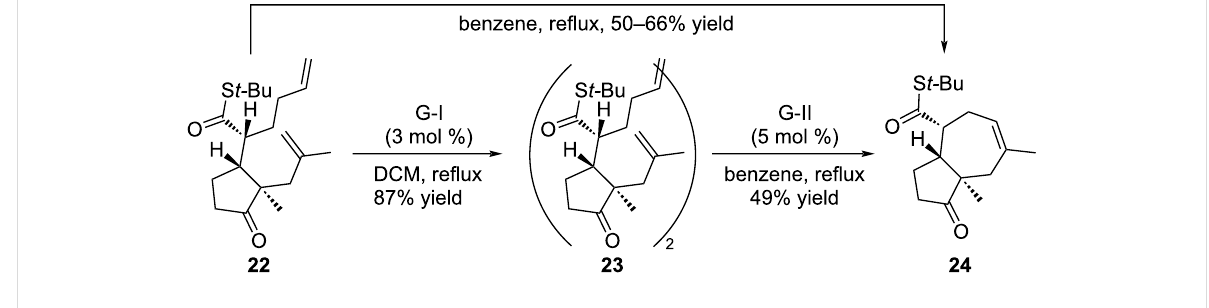
Scheme 3: Ring-closing metathesis attempts starting from thioester 22 .